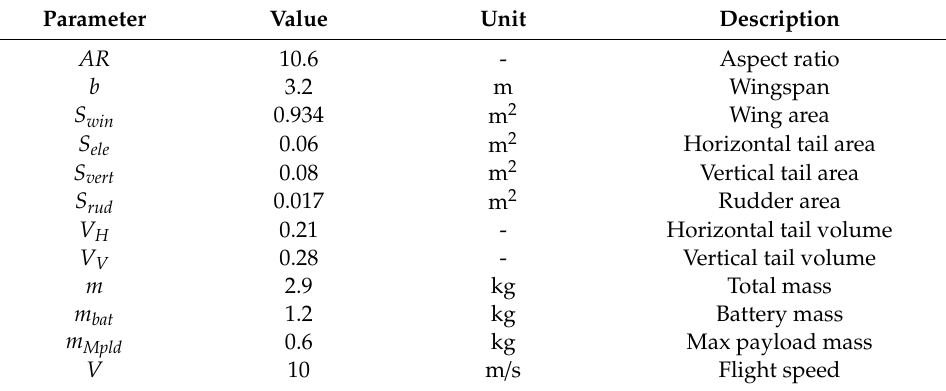
Table 3. Design characteristics of Mini-Phantom Solar